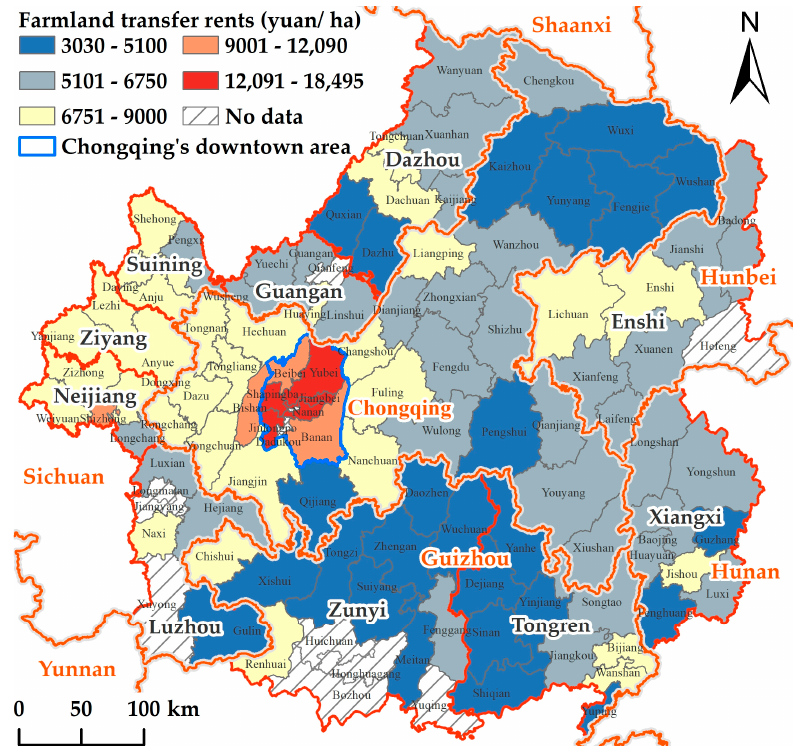
Figure 3. Farmland transfer rents distribution.